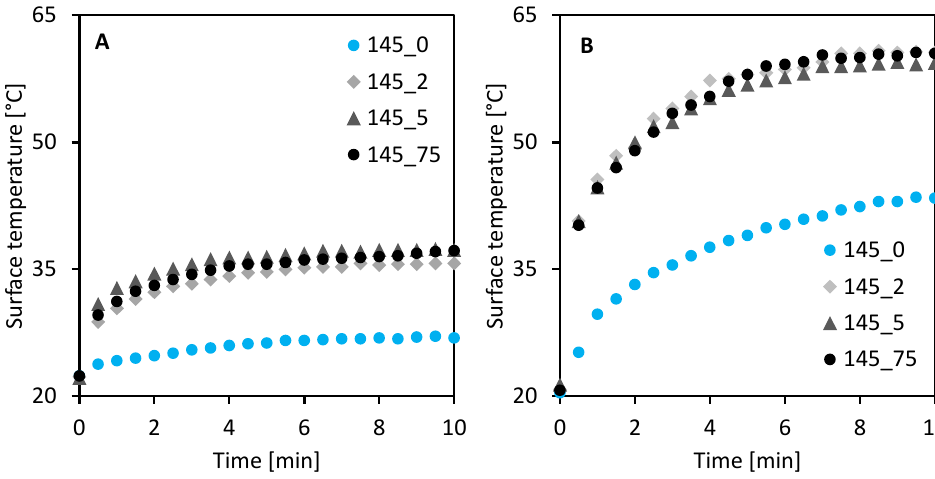
Figure 7. Membrane surface temperature change using ( A ) LED lamp and ( B ) incandescent lamp.